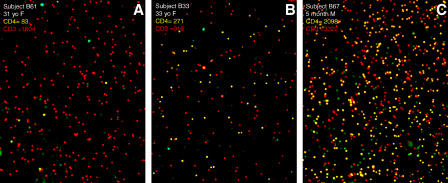
Representative Processed Data Images from Three Participants in BotswanaThe participants included (A) a 31-y-old woman with a CD4 count of 83 cells/μl by flow cytometry; (B) a 33-y-old woman with a CD4 count of 271 cells/μl by flow cytometry; and (C) a 5-mo-old infant with an absolute CD4 count of 2,098 cells/μl and a CD4:CD8 ratio of 1.80 by flow cytometry. In these images, CD3+CD8+ T cells appear red, monocytes appear green, and CD3+CD4+ T cells appear yellow. Each image reflects 0.18 μl of whole blood.